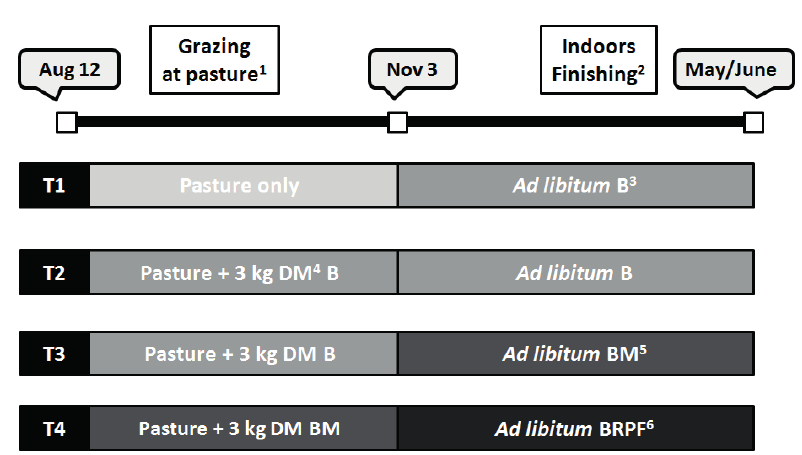
Fig. 1 Experimental overview of the treatments imposed in the study. 1 rotationally grazed at pasture from 12 August to housing on 3 November; 2 housed indoors on a slatted floor accommodation and offered a concentrate ad libitum diet from housing to slaughter; 3 800